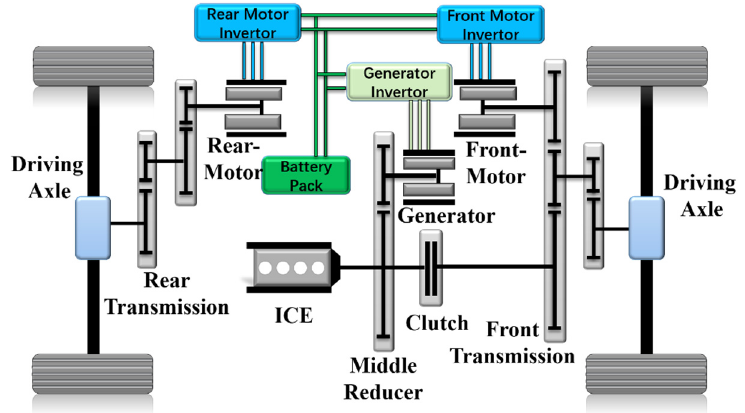
Figure 1. The schematic of the 4DW PHEV configuration. Table 1. Operating states of vehicle components under different modes. Operating Modes